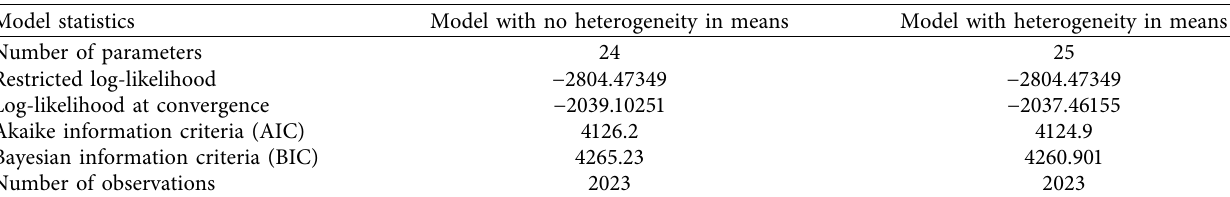
Table 4: Goodness-of-fit of the competing